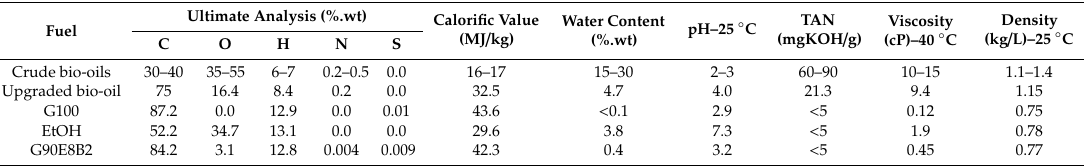
Table 3. Some properties of common crude bio-oils (adapted from [8]), organic bio-oil fraction used in this work, gasoline, ethanol and G90E8B2